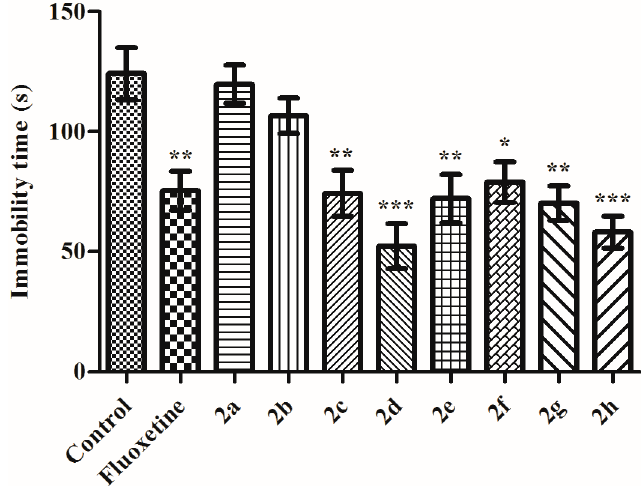
Figure 2. The effects of the test compounds ( 2a – 2h ) and fluoxetine on the immobility time of the mice measured in TST. Significant differences against control group, * p < 0.05, ** p < 0.01, *** p < 0.001. Values are presented as mean ± SEM, ( n = 7).